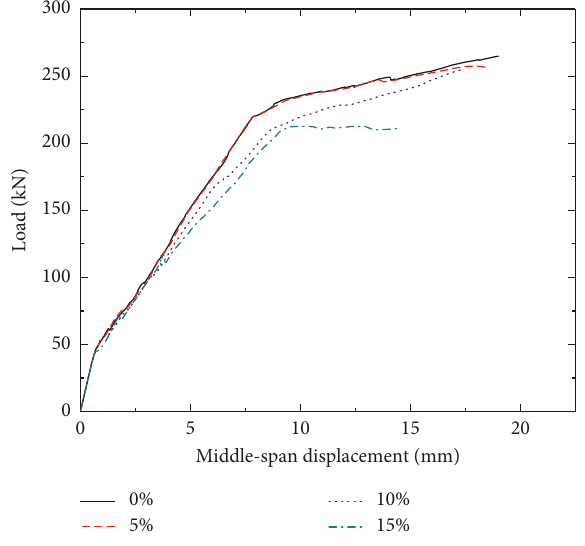
Figure 11: The load-displacement curve due to bonding degradation.